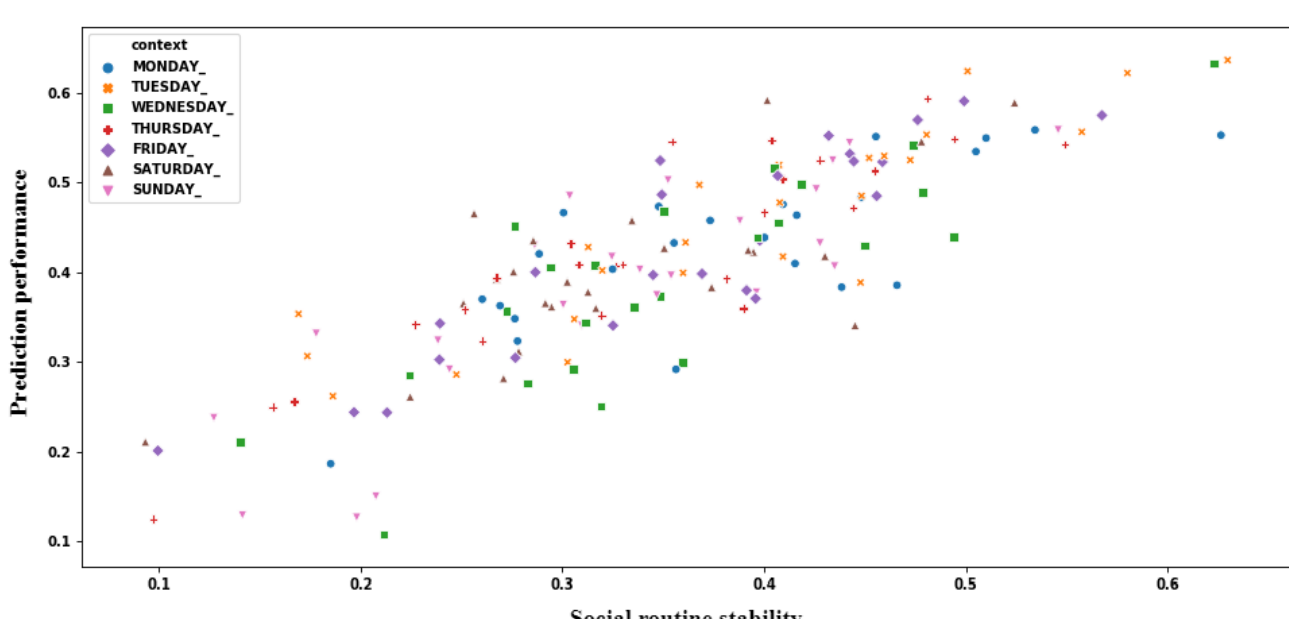
Figure 12. Stability of the individuals’ social routines.